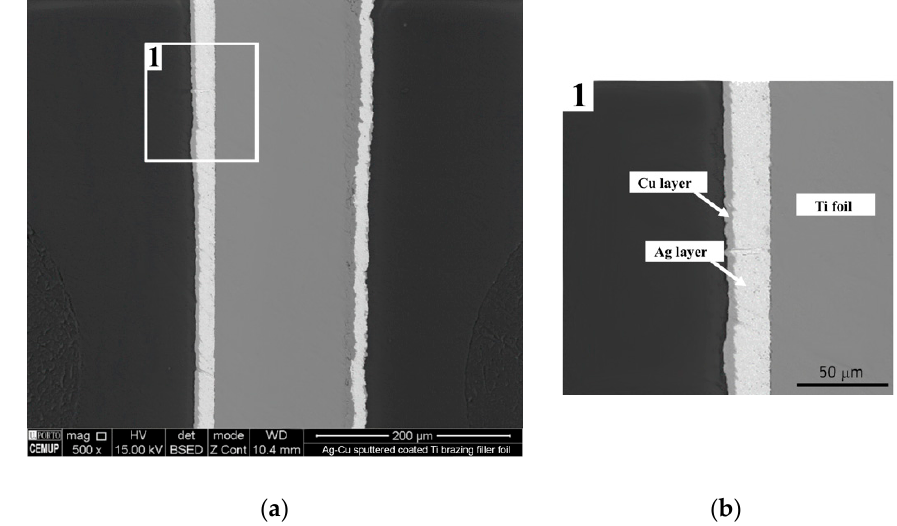
Figure 1. Backscattered electron images (BEIs) of the as-sputtered brazing filler showing the Cu and Ag layers on Ti foil: ( a ) global view; and, ( b ) magnification of the zone indicated in ( a